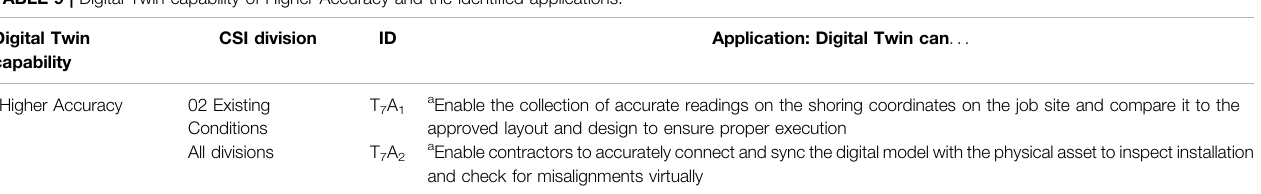
TABLE 9 | Digital Twin capability of Higher Accuracy and the identi fi ed